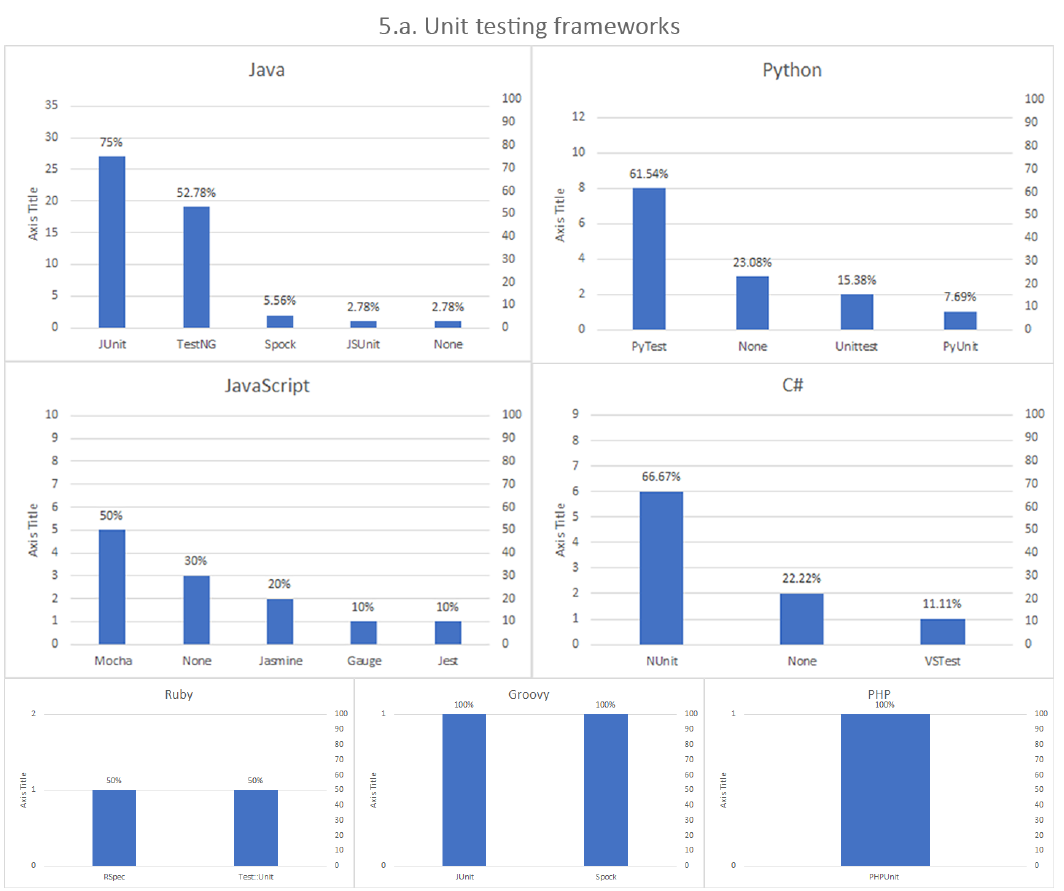
Figure 11. Unit testing frameworks used in conjunction with